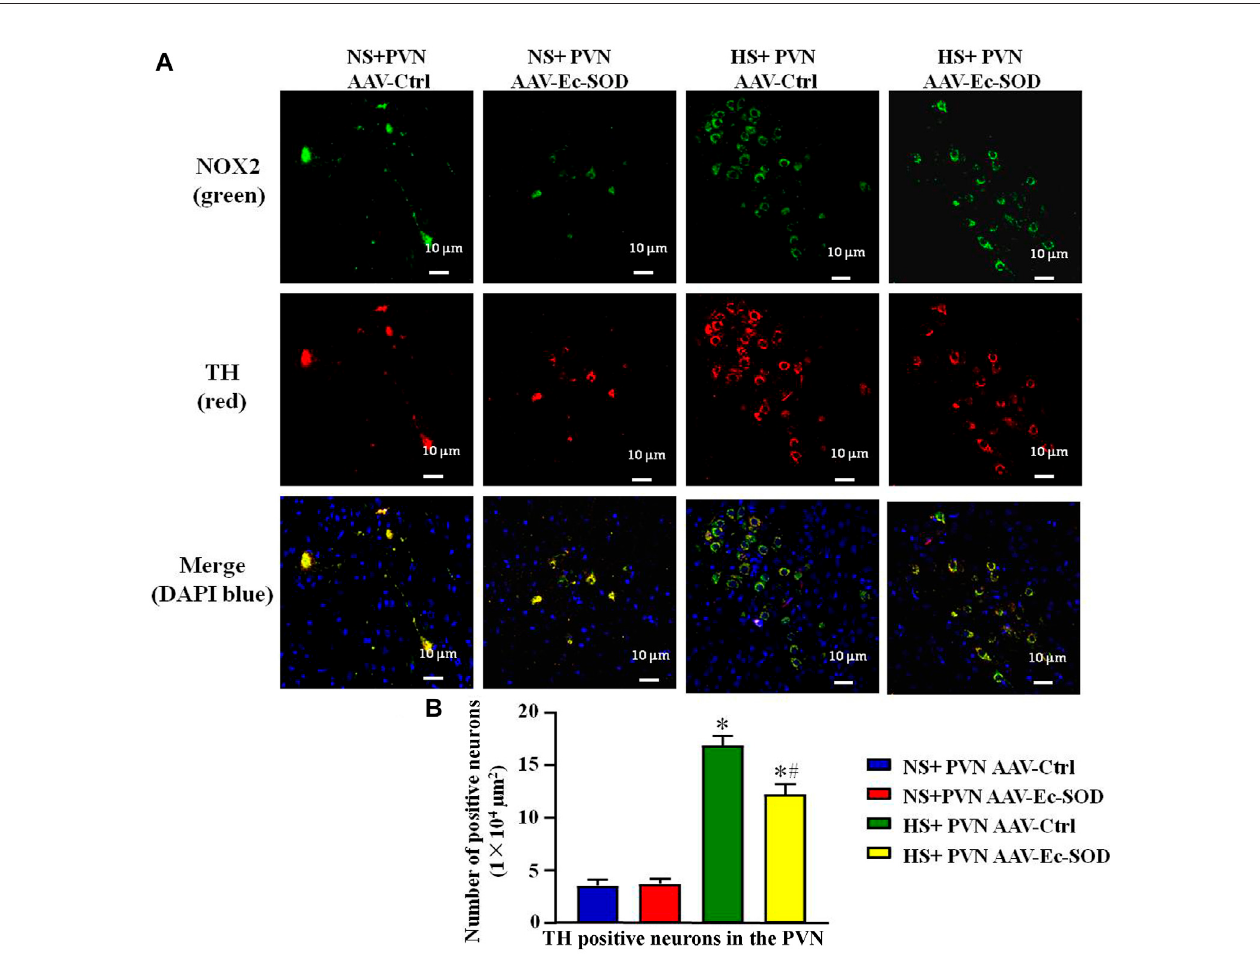
FIGURE 6 | Effect of AAV-Ec-SOD on the NOX2 and TH-positive neurons in the PVN. (A) Double fl uorescence staining for NOX2 and TH-positive neurons in the PVNindifferentgroups. (B) ColumndiagramshowingtheTH-positiveneuronsinthePVNindifferentgroups.Valuesareexpressedasmean ± SEM(n (cid:2) 6).* p < 0.05NS + PVN AAV-Ctrl vs. HS + PVN AAV-Ec-SOD; # p < 0.05 HS + PVN AAV-Ctrl vs. HS + PVN